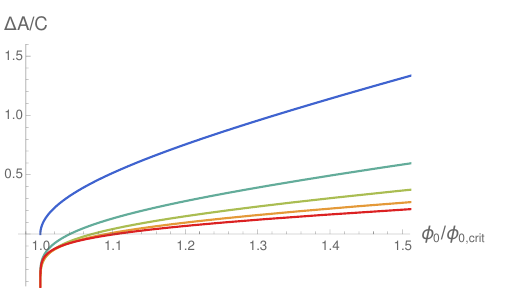
Figure 5 . Area difference between island and HM surfaces at t = 0 , ∆ A = A island − A t =0 normalized to C in (3.7), from top to bottom for d = 2 , 3 , 4 , 5 , 6